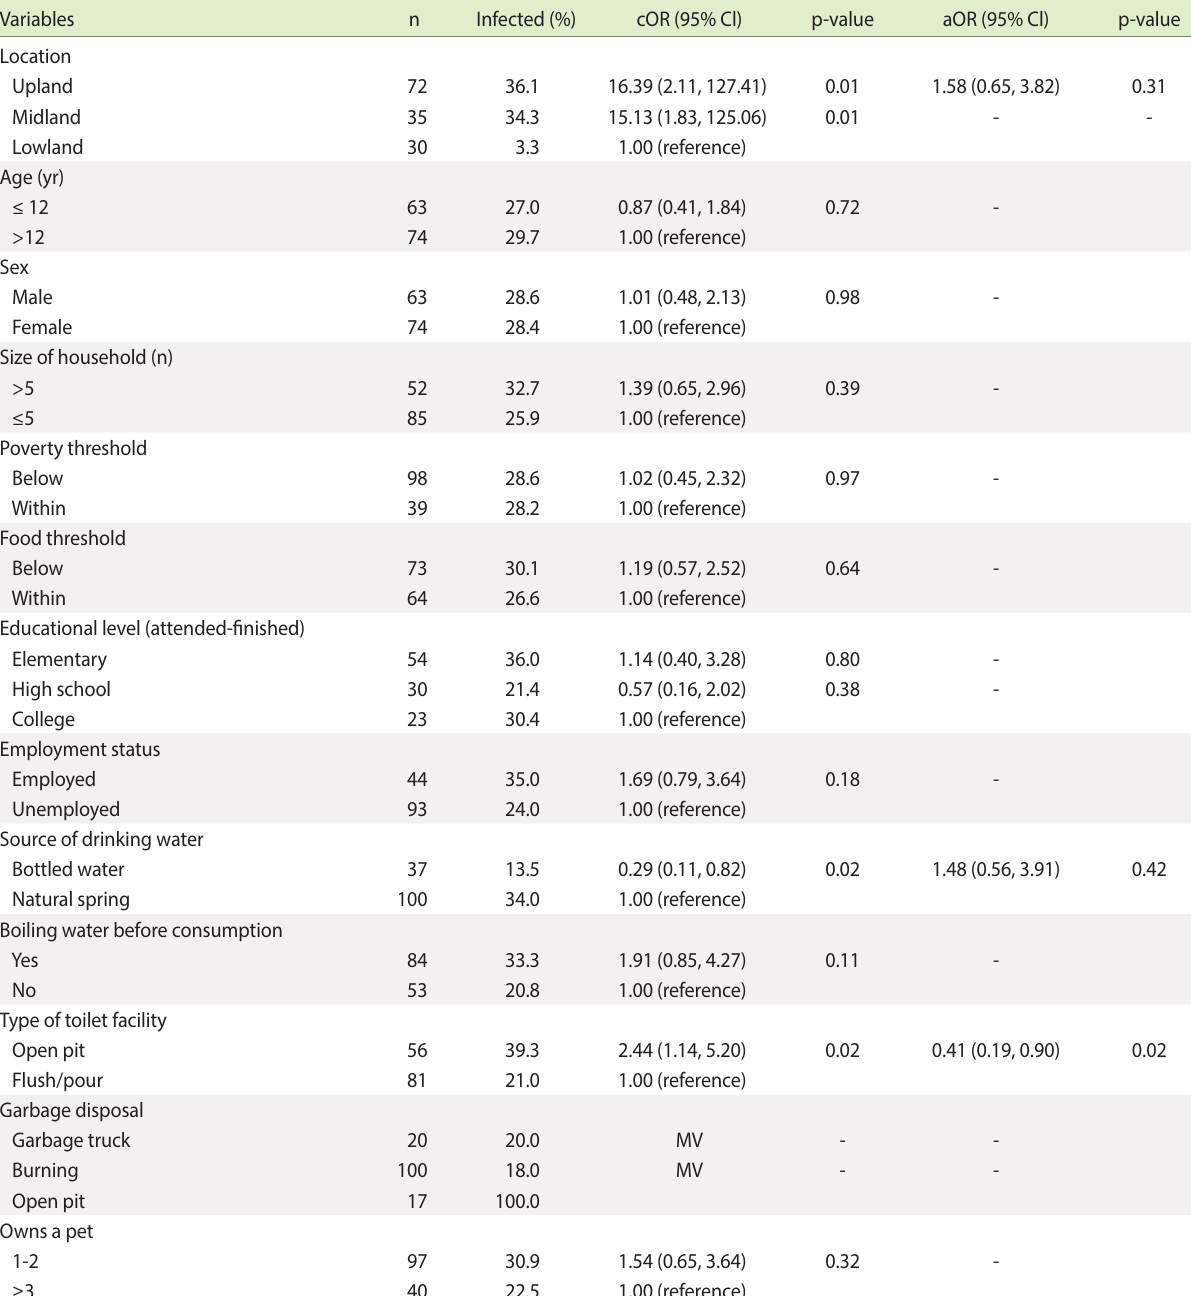
Table 2. Univariate and multivariate analysis of factors associated with Cryptosporidium infection Variables